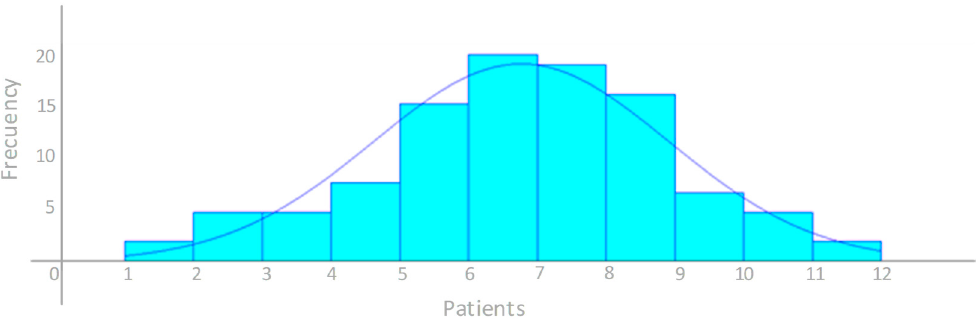
Figure 6. Histogram generated for daily patient arrival.